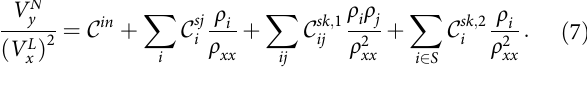
sj i ), intrinsic skew-scattering ( C sk ; 2 ij ) contributions, respectively.